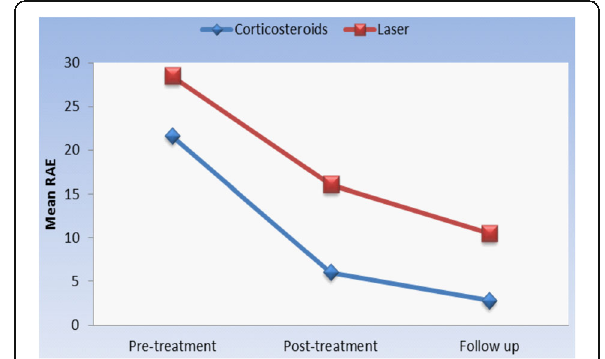
Fig. 1 Changes in mean pain (VAS) scores in the corticosteroid and laser groups